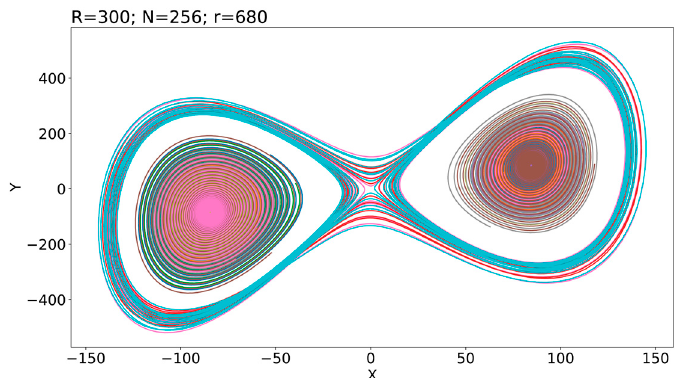
Figure 5. The coexistence of chaotic and non-chaotic orbits within the GLM with M = 9; 256 ICs distributed over a hypersphere with a radius of 300. τ ∈ [0 . 625 , 5] with ∆ τ = 0 . 001.